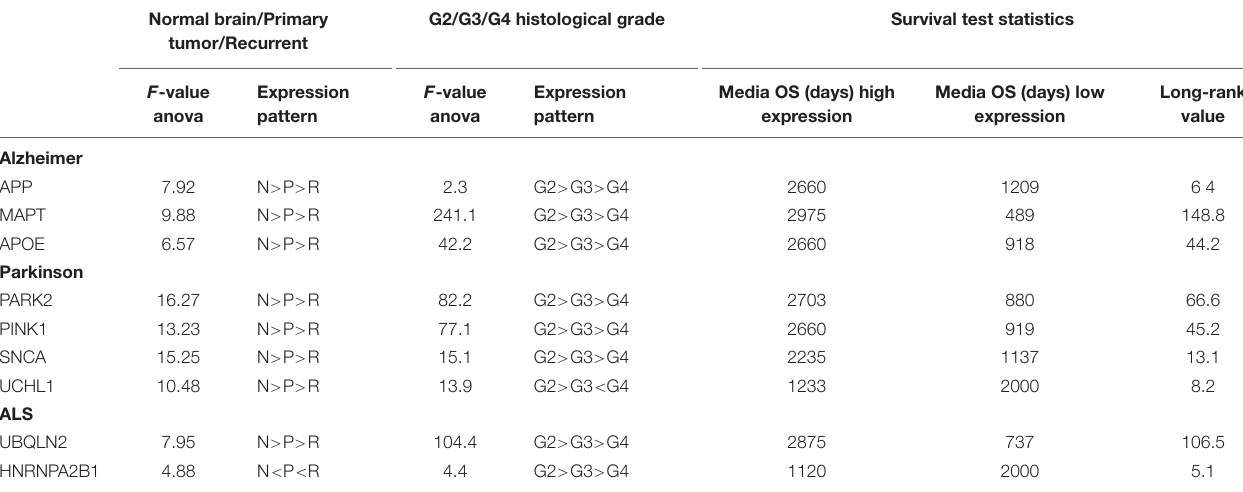
TABLE 1 | Correlation of the expression of different neurodegeneration-related genes with the clinical evolution of gliomas. Normal brain/Primary G2/G3/G4 histological tumor/Recurrent